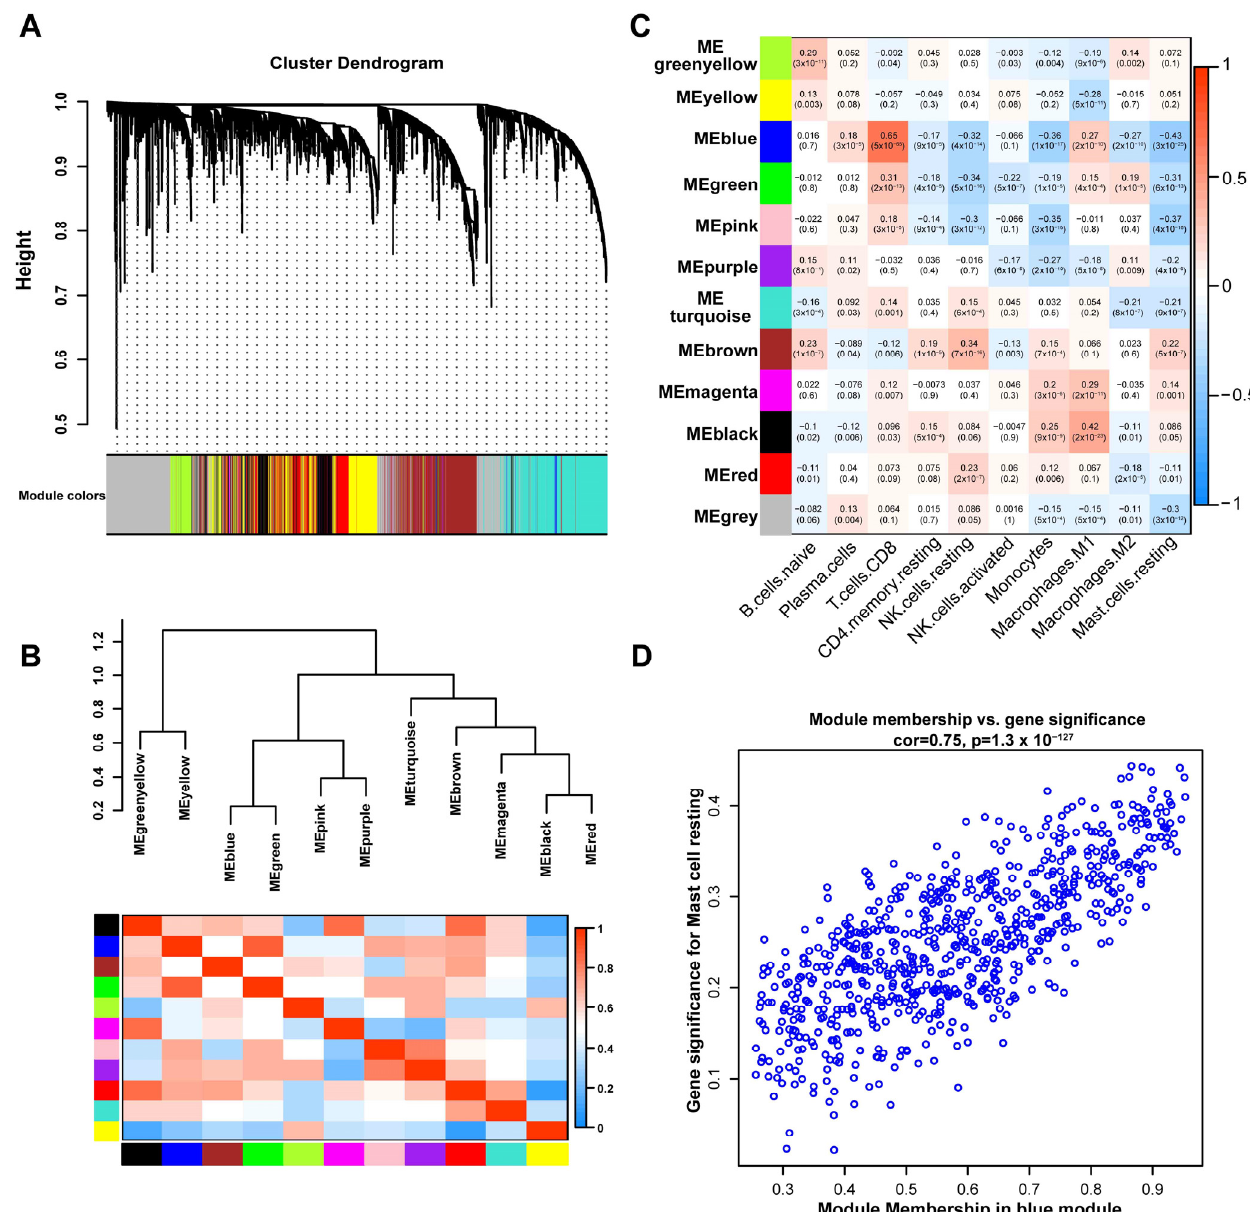
Figure 4. Identification and validation of the key modules closely related to RMCs. ( A ) Hierarchical clustering tree of DEGs based on the TCGA dataset. ( B ) Cluster dendrogram and heat map of the module eigengenes. ( C ) Heat map describing the relationship between the module eigengenes and the infiltration of the top ten TIICs. ( D ) Scatter plot of gene significance for RMCs vs. module membership in the key blue module.